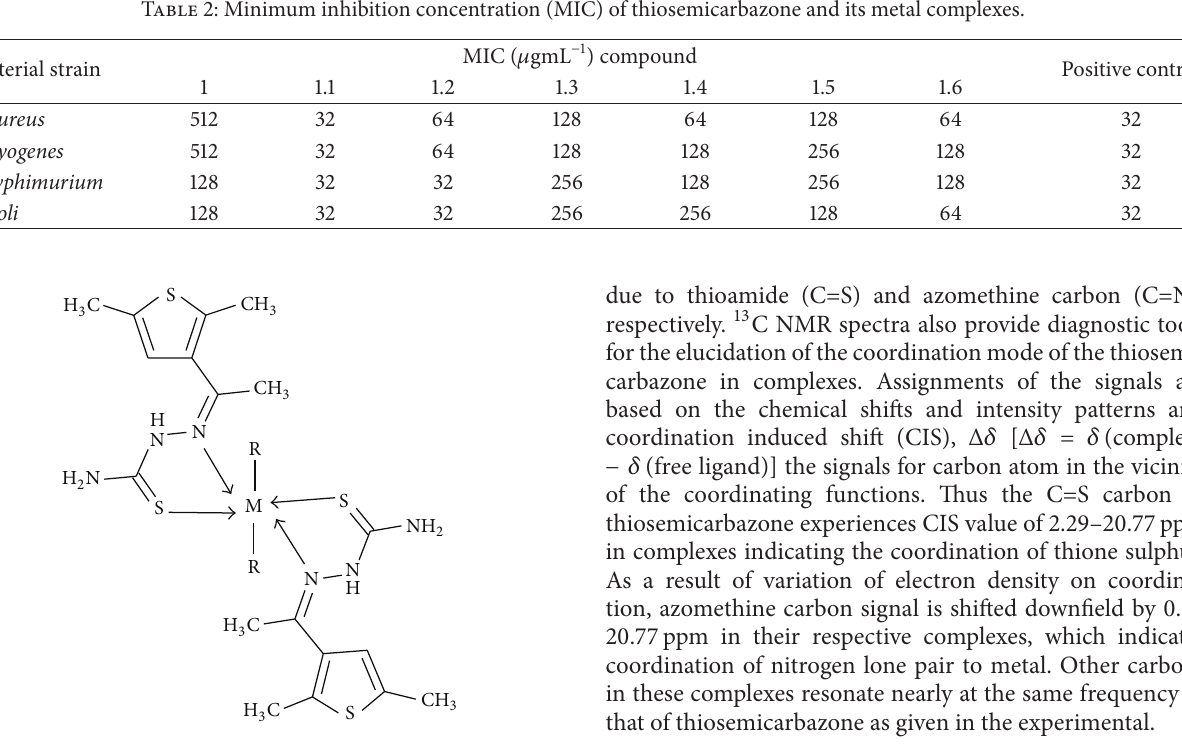
Figure 1: Structure of metal complexes, where R is AcO, Cl, and M is Cu(II), Ni(II), and